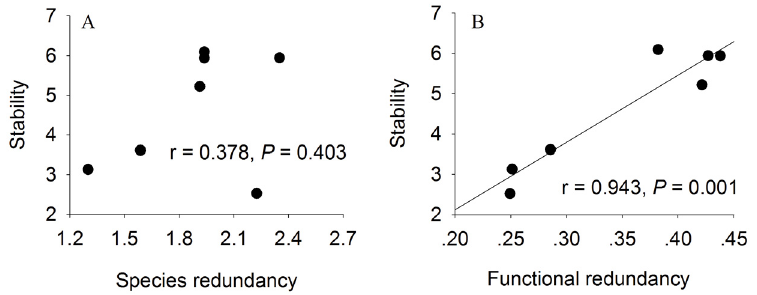
Fig 4. Trend in stability with species redundancy (panel A) and functional redundancy (panel